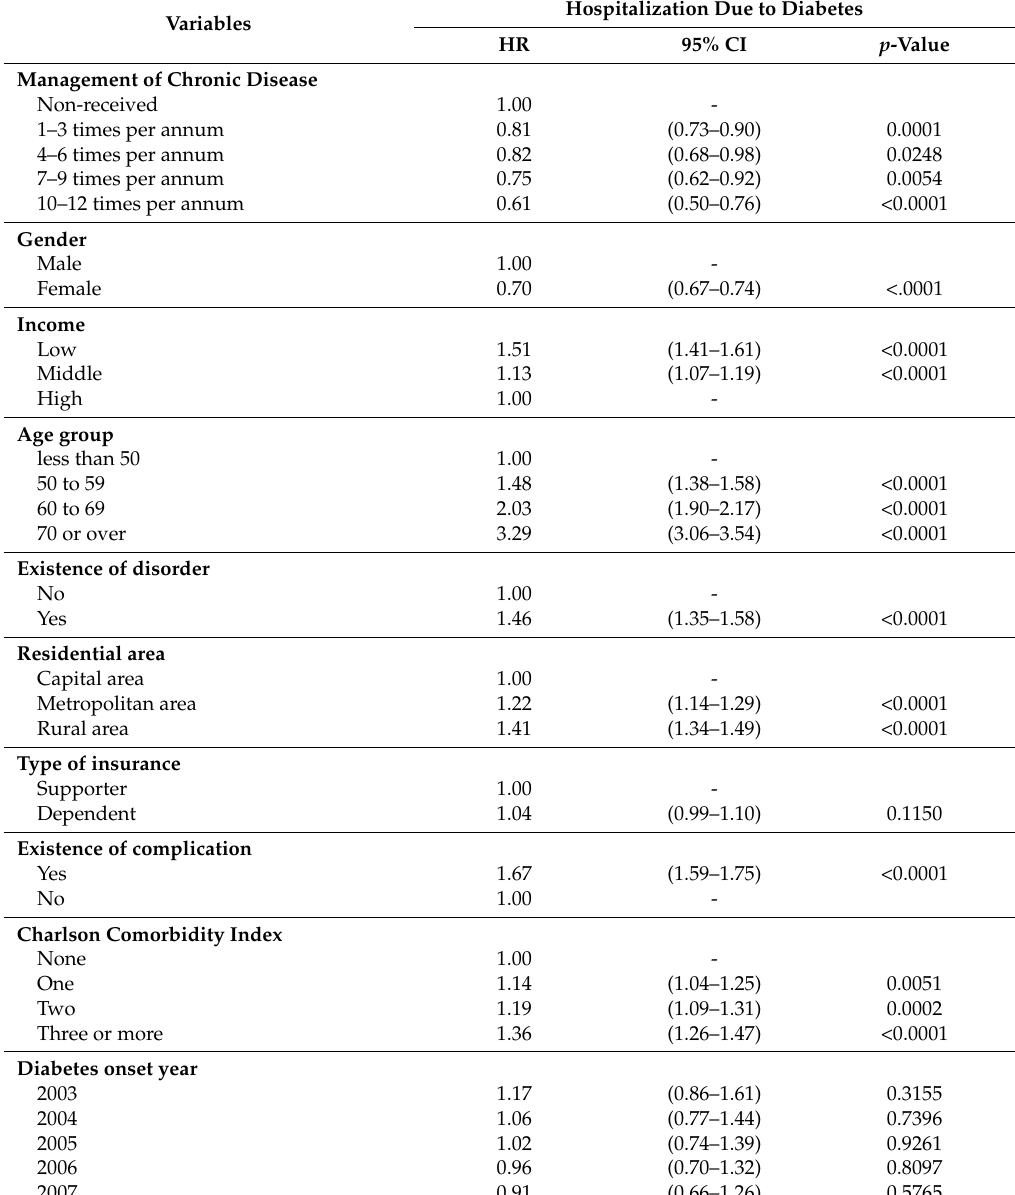
Table 2. Factors associated with hospitalization due to diabetes by cox proportional hazards regression model. Hospitalization Due to Diabetes Variables HR 95% CI p